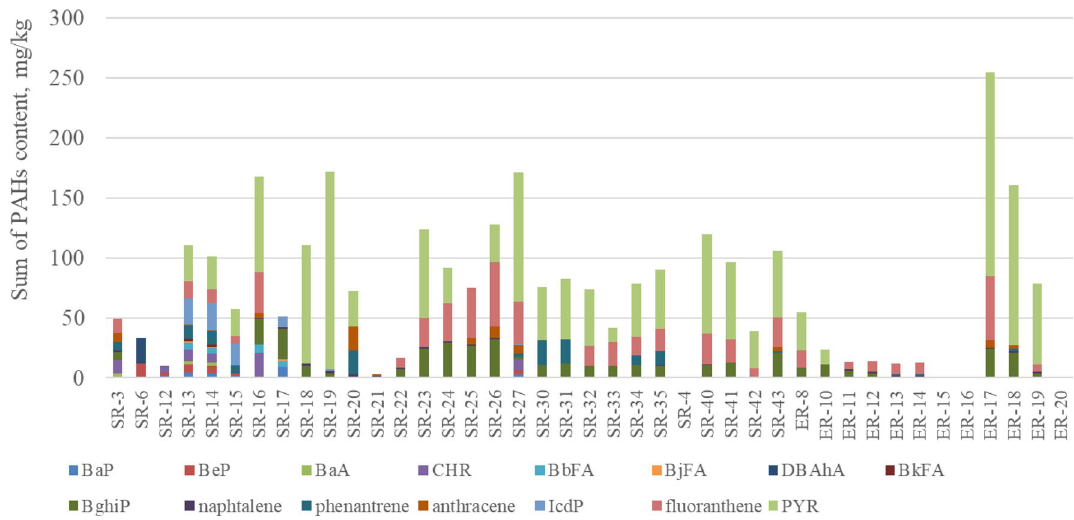
Figure 5. Sum of the PAHs content in the tested samples of rubber granules supplied by recyclers. SR SBR granulate sample provided by the recycler, ER EPDM granulate sample provided by the